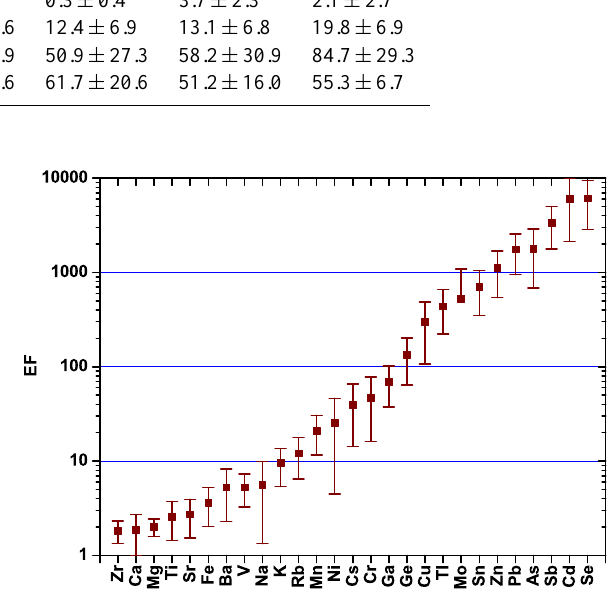
Figure 3. Enrichment factors of trace elements. Figure 3. 24.5 ± 8.4, 5.7 ± 1.5, 6.3 ± 4.8, 0.9 ± 0.3, 42.2 ± 9.0, and 12.2 ± 3.0 %,